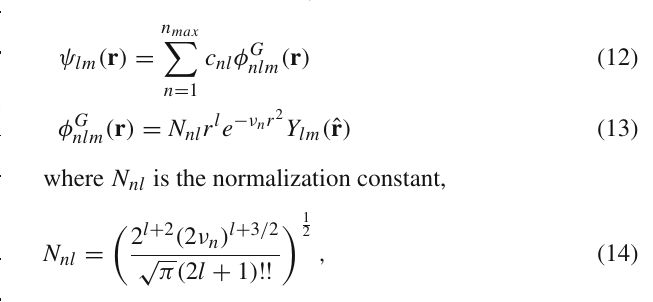
Table 2 The masses of ground-state baryons and mesons (unit: Mev)